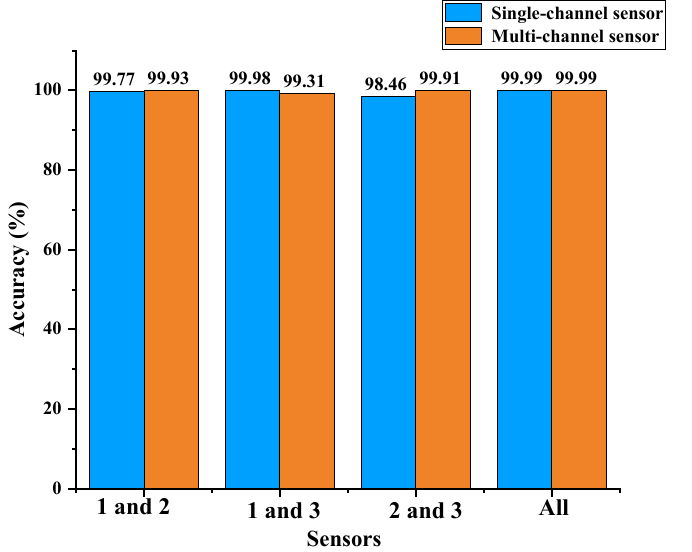
Figure 22. Accuracy comparison of sensor single-channel and sensor multi-channel after fusion.